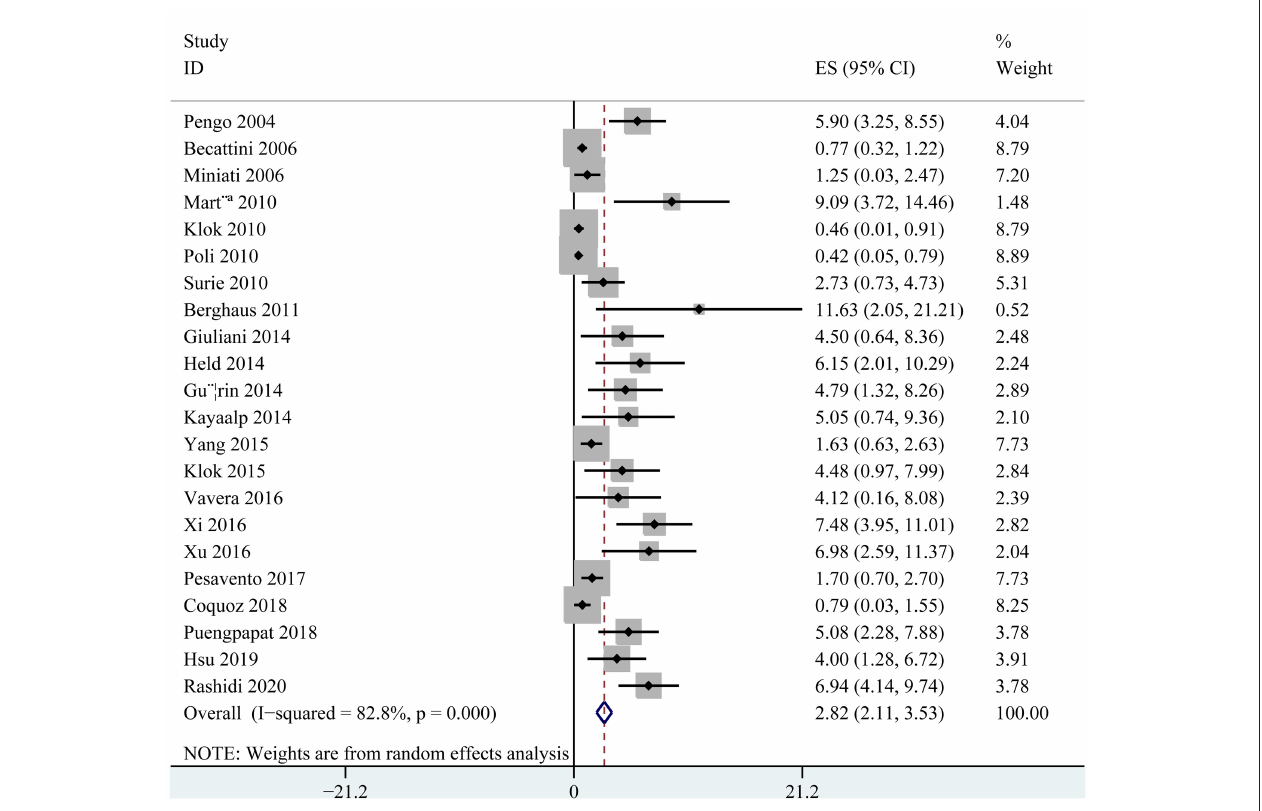
FIGURE 2 | Forest plots for the meta-analysis of the incidence of CTEPH in patients after acute